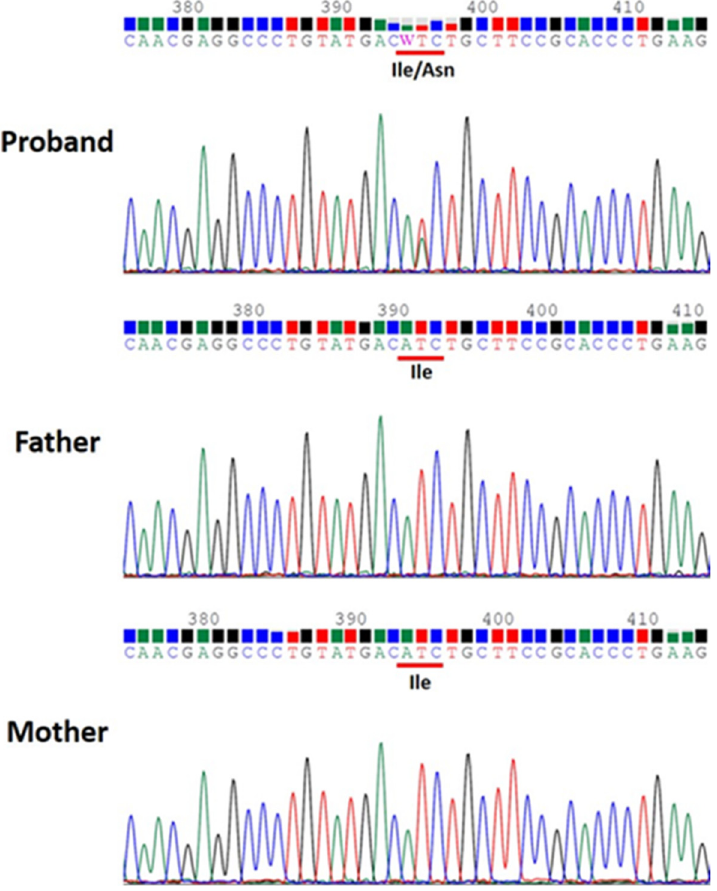
Figure 3. Sanger sequencing confirmed TUBB2B de novo mutation (NM_178012.5:c.629T>A; p.Ile210Asn) of Case 1 identified by whole exome sequencing (WES).